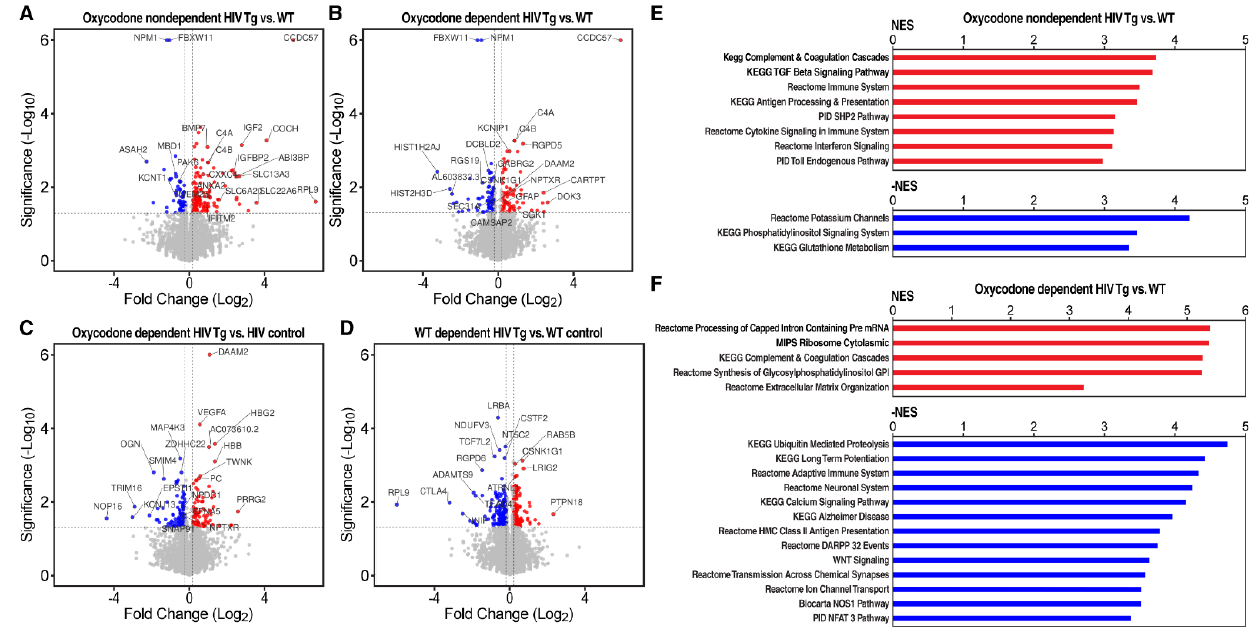
Figure 2. Gene expression profiling in the mPFC in HIV Tg and WT rats that self-administered oxycodone under nondependent (ShA) and dependent (LgA) conditions. ( A ) Volcano plot of changes in gene expression in the mPFC in HIV Tg rats with a history of oxycodone self-administration under ShA conditions compared with oxycodone-self-administering WT rats under the same conditions. The plots show significance (Log10 of p value) vs. fold-change (Log2) on the y and x axes, respectively. Genes that significantly increased in HIV Tg rats vs. WT rats with oxycodone self-administration under ShA conditions are indicated in red. Genes that significantly decreased are indicated in blue. ( B ) Volcano plot of changes in gene expression in the mPFC in HIV Tg rats with a history of oxycodone self-administration under LgA conditions compared with oxycodone-self-administering WT rats under the same conditions. Genes that significantly increased in HIV Tg rats vs. WT rats that self-administered oxycodone under LgA conditions are indicated in red. Genes that significantly decreased are indicated in blue. ( C ) Volcano plot of changes in gene expression in the mPFC in HIV Tg rats with a history of oxycodone self-administration under LgA conditions compared with oxycodone-naive HIV Tg rats and ( D ) volcano plot of changes in gene expression in the mPFC in